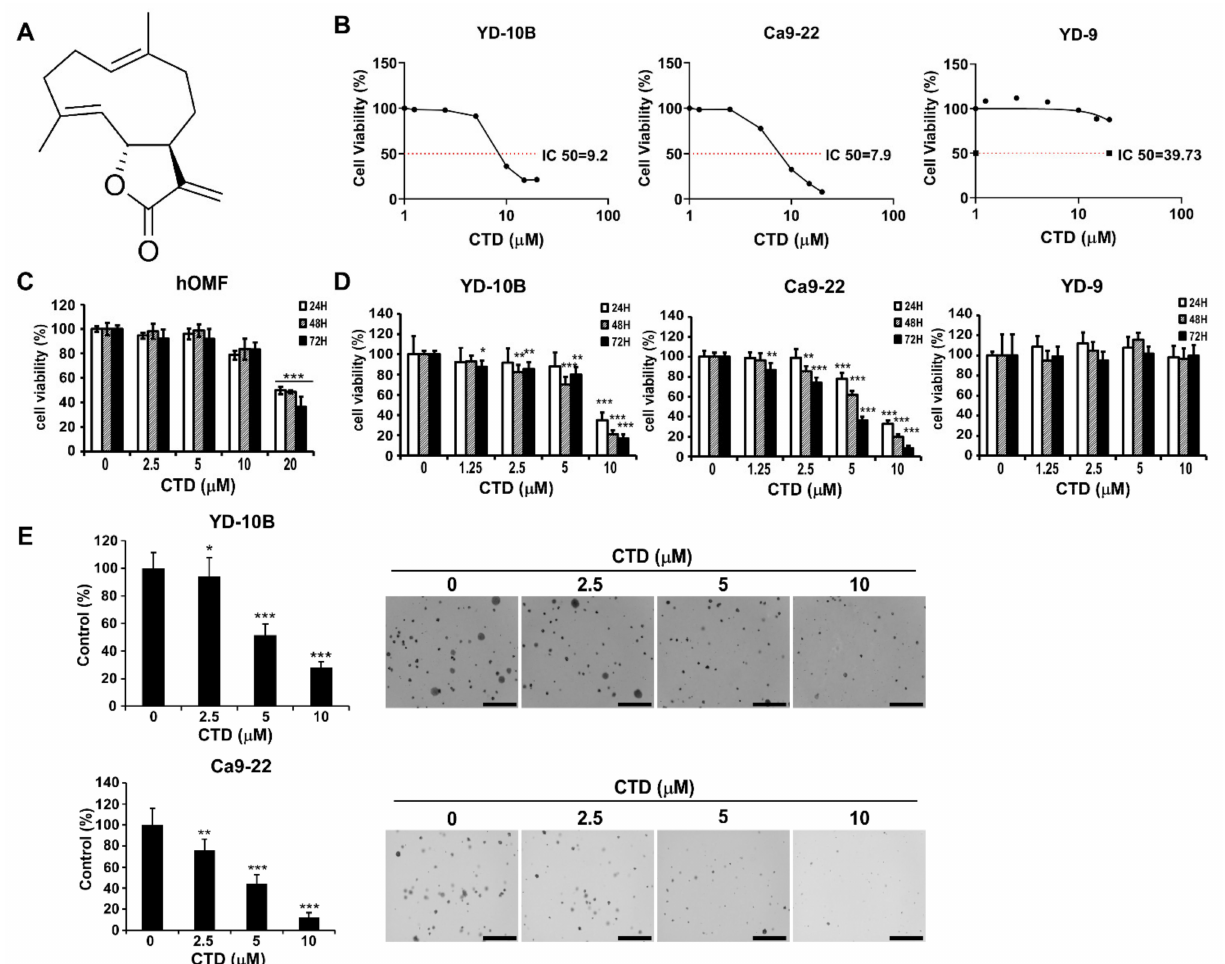
Figure 3. Costunolide inhibits proliferation of oral cancer cells. ( A ) The structure of Costunolide. ( B ) The IC50 value of oral cancer cells (YD-10B, Ca9-22 and YD-9) was examined by MTT assay at 24 h. ( C ) The effects of CTD on the growth of healthy oral epithelial cells. ( D ) The effects of CTD on the growth of YD-10B, Ca9-22 and YD-9 oral cancer cells were determined by the MTT assay at 24, 48 and 72 h. ( E ) The effects of CTD on the colony formation of oral cancer cells were evaluated by the soft agar assay and representative photographs of colony formation are shown (100 × ). Data are represented as mean ± SD of values from triplicate samples; * p < 0.05, ** p < 0.01 and *** p < 0.001 indicate a significant difference compared with